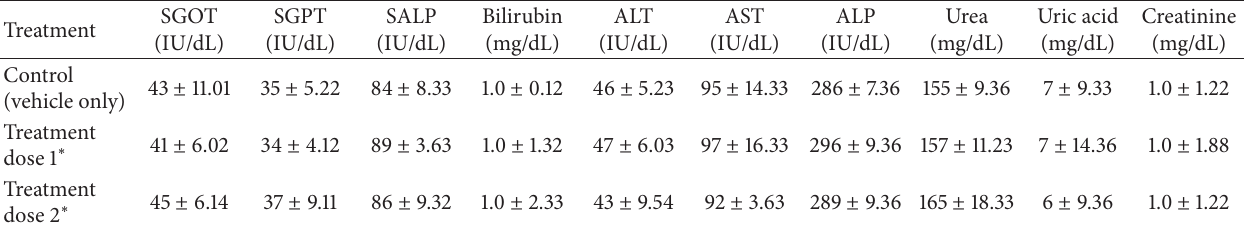
Table 2: Effect of p-PD treatment on serum biochemical parameters of mice.